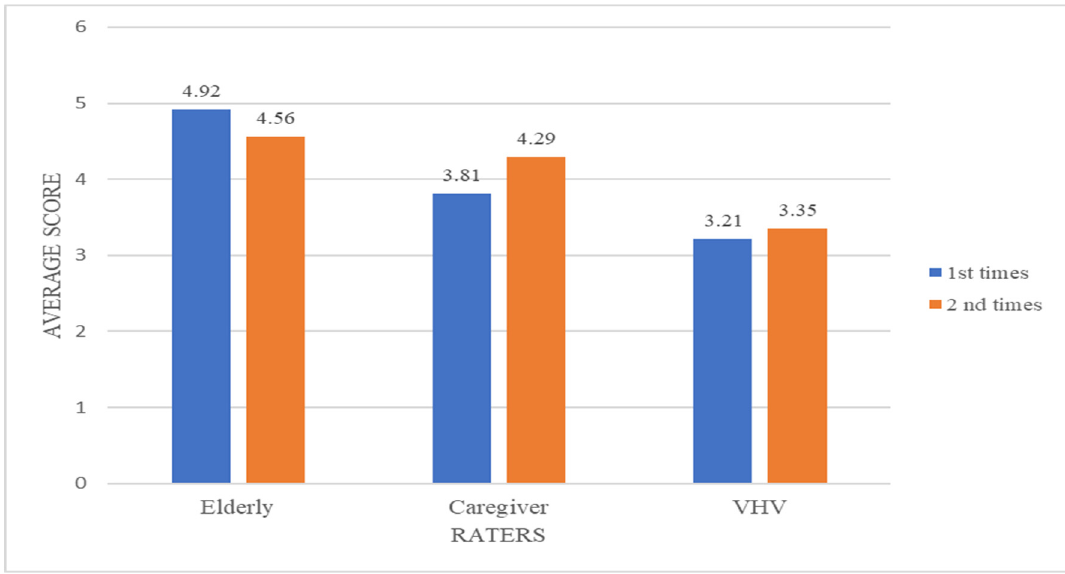
Figure 2. The average scores from the elderly caregivers and VHVs for the 1st and 2nd visit.